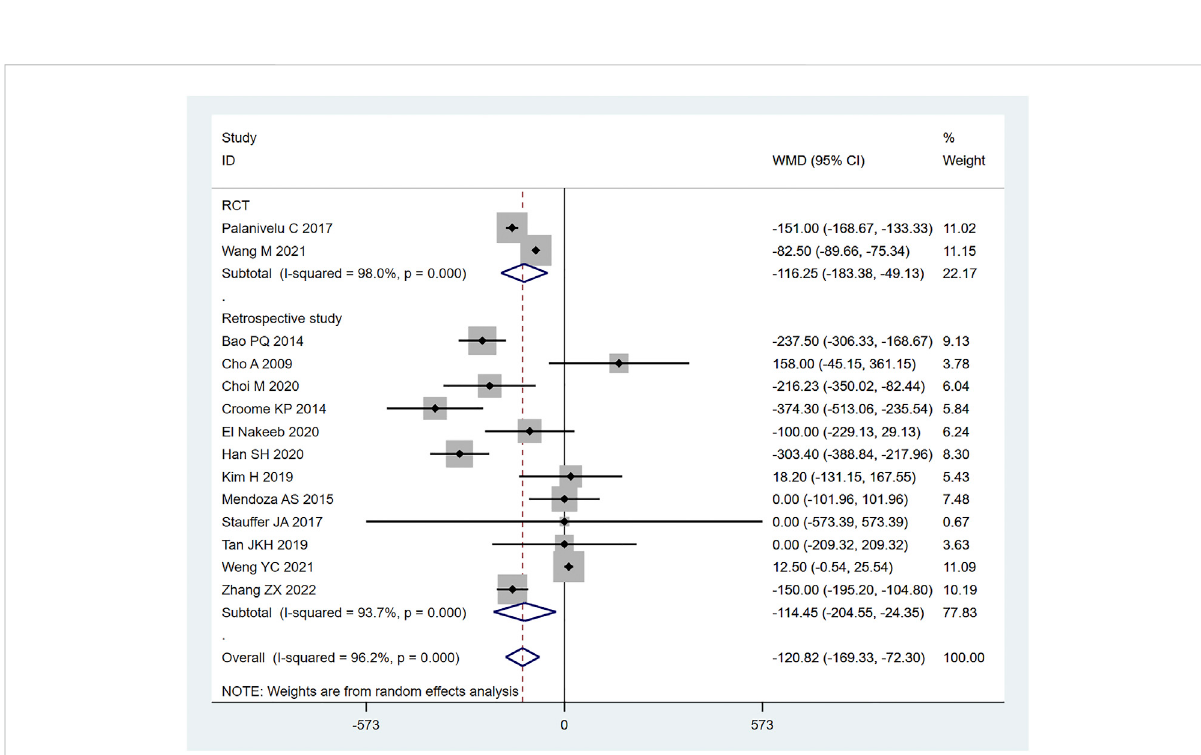
FIGURE 4 Forest plot of Meta-analysis of intraoperative blood